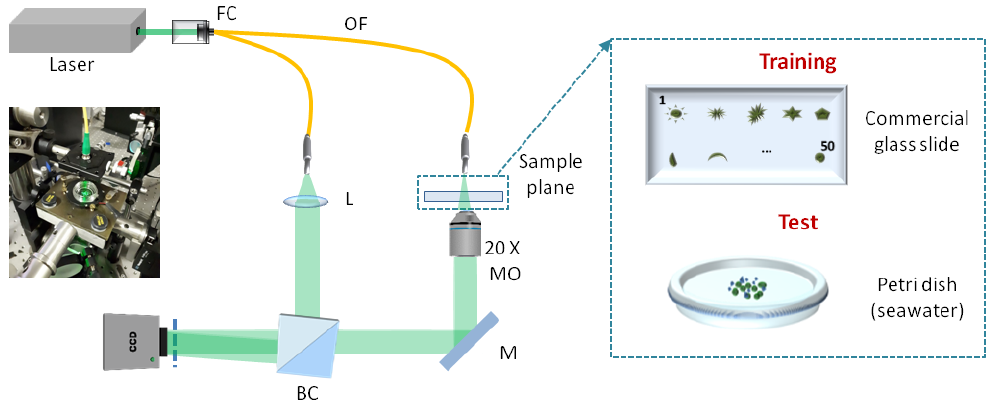
Figure 1. Experimental setup. FC: Fiber coupler; OF: Optical Fiber; BC: Beam Combiner; M: Mirror; MO: Microscope Objective; L: lens.